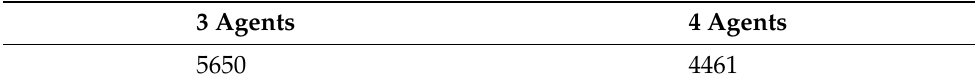
Table 1. Number of episodes compound conflicts